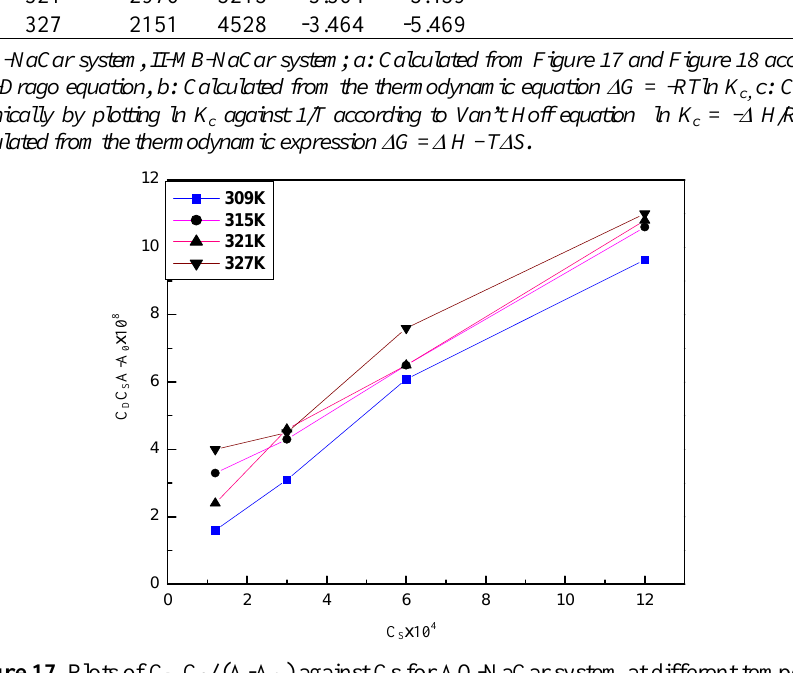
.C / (A-A ) against Cs for AO-NaCar system at different temperatures D S O